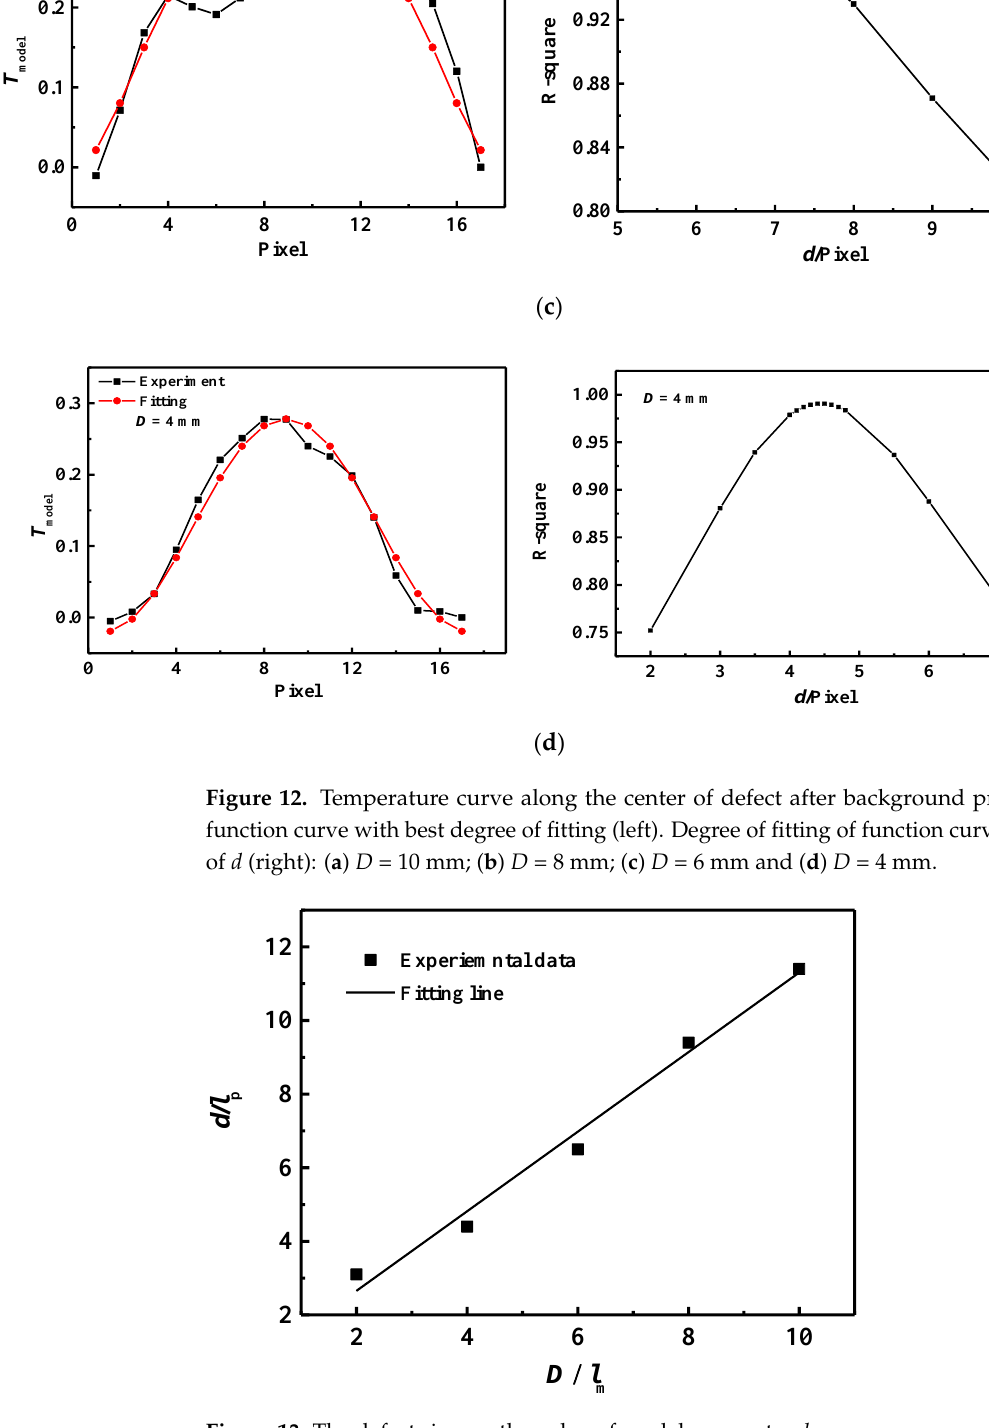
Figure 13. The defect size vs. the value of model parameter d .